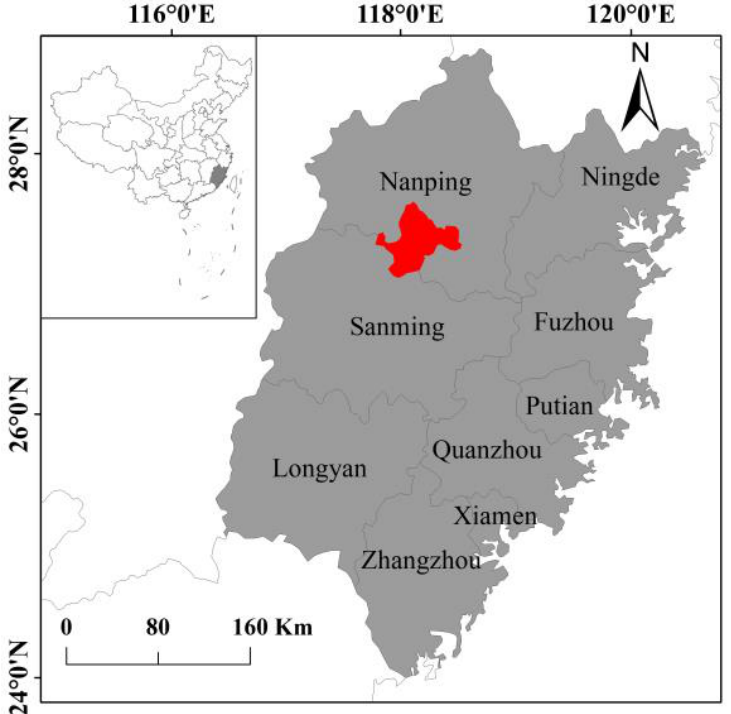
Figure 1. Location of Shunchang County, Nanping City, Fujian Province, China.